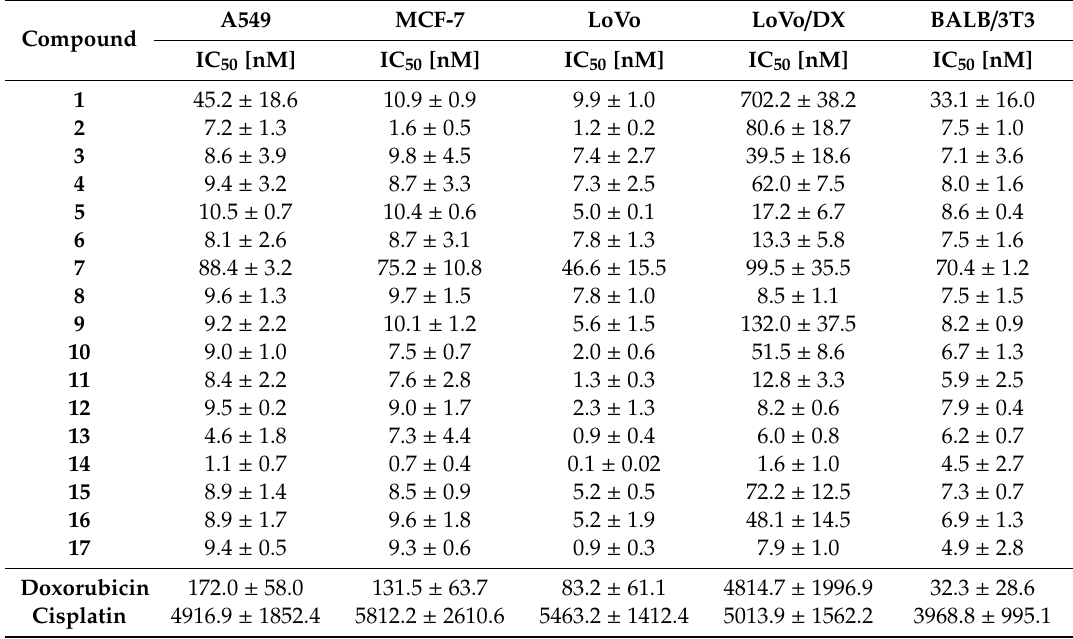
Table 1. Antiproliferative activity (IC 50 ) [nM] of colchicine ( 1 ) and its derivatives ( 2 – 17 ) compared with that of standard anticancer drugs doxorubicin and